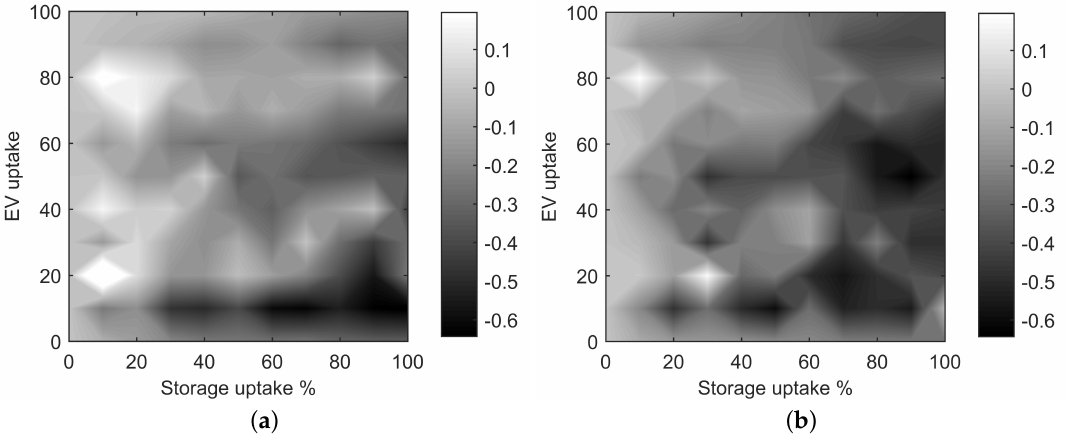
Figure 11. Comparison of line utilisation improvement indices for ( a ) AIMD and ( b ) AIMD+. (a) ζ ∗∗ indices (AIMD); (b) ζ ∗∗ indices (AIMD+). D C